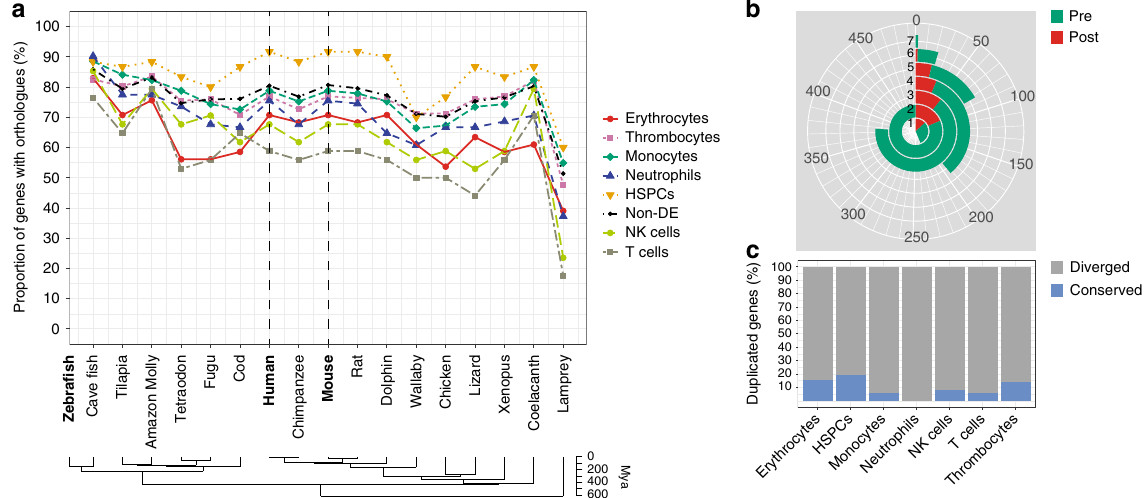
Fig. 6 Conservation analysis of zebra fi sh genes differentially expressed in the main blood cell types. a Percentage of zebra fi sh protein-coding genes (speci fi c for distinct blood cell types, as well as non-differentially expressed) with orthologs in other vertebrate species. b The total number of paralogs duplicated exclusively pre- (green) and post-ray- fi nned speciation (red). The numbers 1 – 7 mark the number of cell types (erythrocytes, monocytes, neutrophils, thrombocytes, HSPCs, T cells and NK cells) in which the duplicated genes are expressed. c The percentage of conserved vs diverged genes duplicated exclusively post speciation ( fi sh-speci fi c